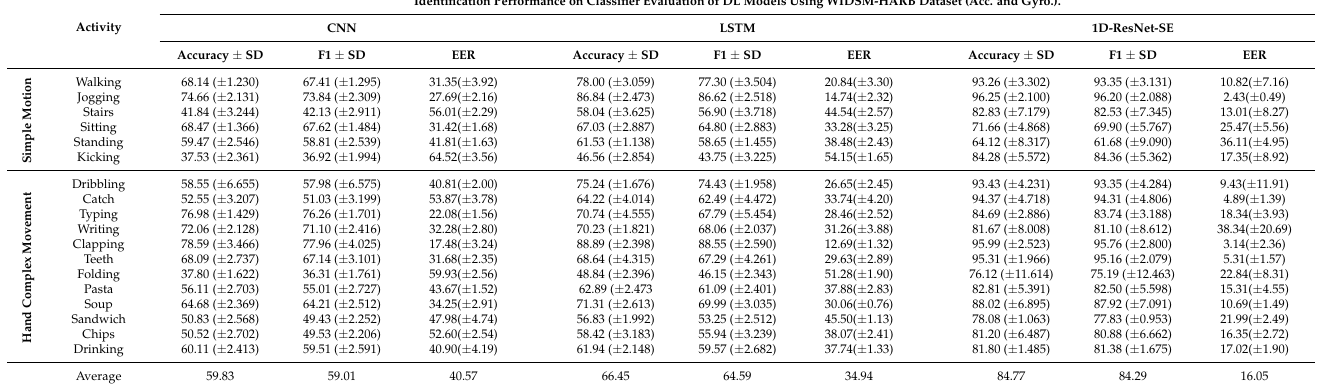
Table 5. Recognition effectiveness on classifier evaluation of deep learning models using WIDSM- HARB dataset (Acc. and Gyro. sensors).